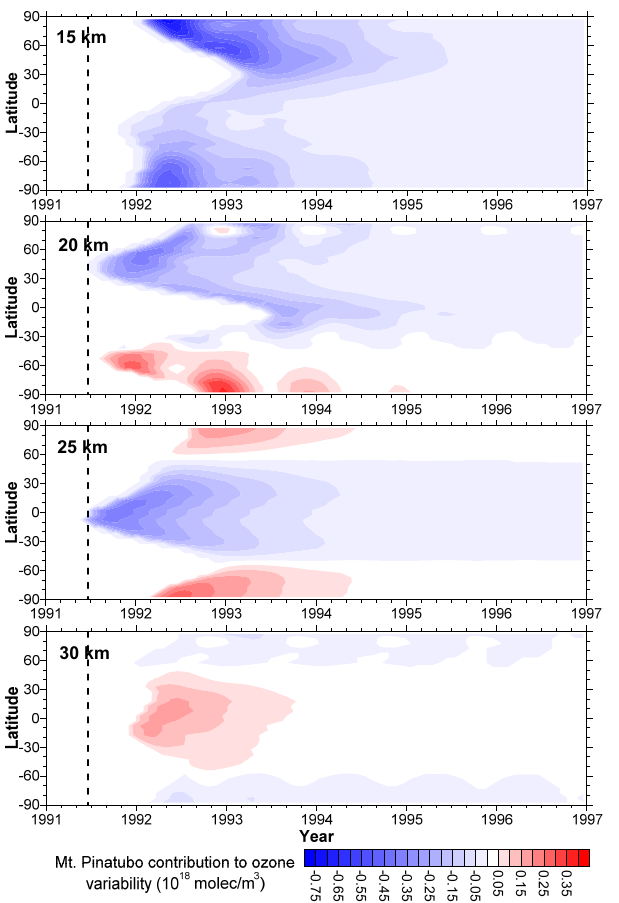
Figure 5. The contribution of Mt. Pinatubo volcanic eruption to ozone variability at 15, 20, 25 and 30km. Red regions show increases in ozone while blue regions show decreases.